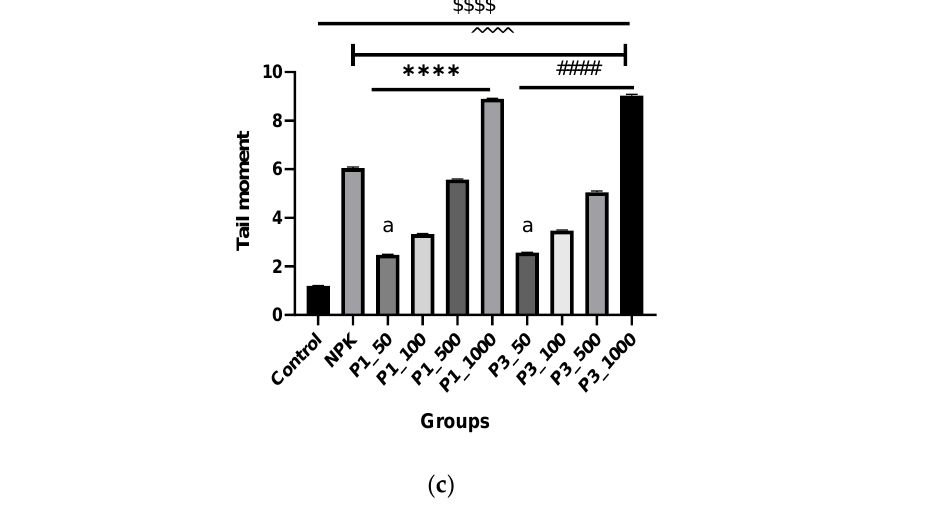
Figure 11. DNA damage represented as tail length (μm) ( a ), percentage of DNA in tail ( b ), and tail moment ( c ) in different groups. Results are expressed as mean ± SE, $ (dollar sign) significant difference with negative control at p < 0.0001, * (asterisk) statistically compared P1 (nHAP_PPE) groups with the P1_50 and # (number sign) statistically compared P3 (nHAP_CE) groups with the P3_50. ^ (circumflex accent) statistically compared with NPK. Different letters refer to statistically significant differences between groups at p ≤ 0.001, while the same letters refer to non -significant (ns) differences between groups at p ≤ 0.05, using one - way ANOVA followed by Tukey’s test. **** indicates p ≤ 0.0001, ***, indicates p ≤ 0.001, ** indicates p ≤ 0.01 (that was applied to the other signs). P1 = nHAP_PPE, P3 = nHAP_CE.